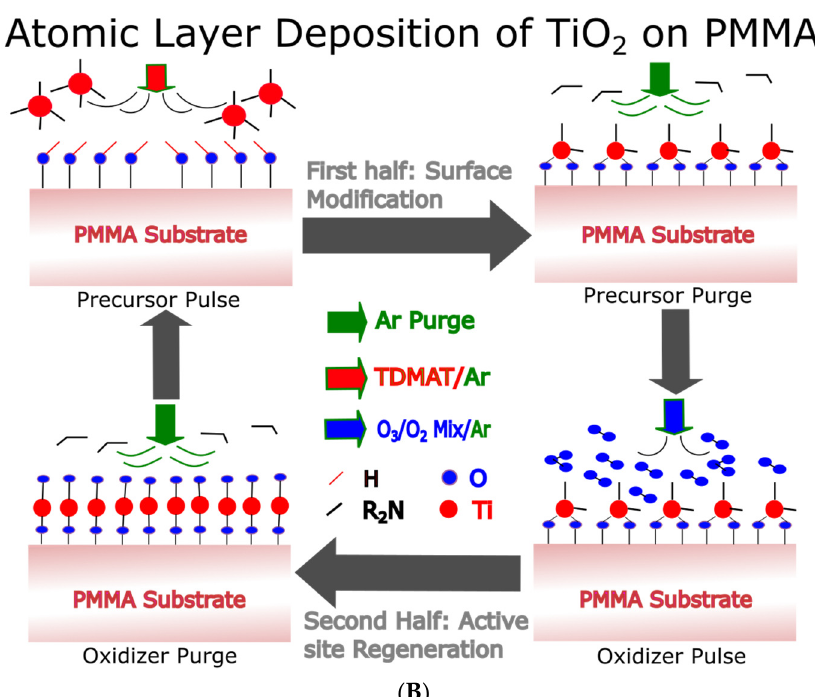
Figure 2. ( A ) . Nano-coating of PMMA specimen by Atomic Layer Deposition. ( B ). Schematic of ALD reaction on O-plasma treated PMMA using TDMAT and O 3 /O 2 mixture.